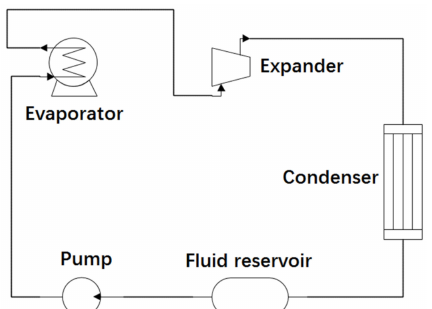
Figure 3. Schematic of the organic Rankine cycle (ORC) system.